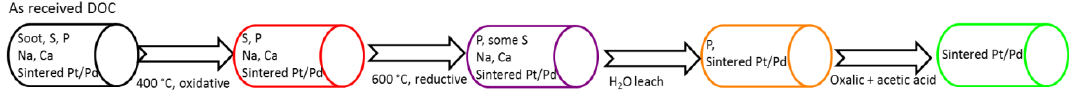
Figure 5. Schematic showing the e ff ect of the contaminant removal procedures on the presence of